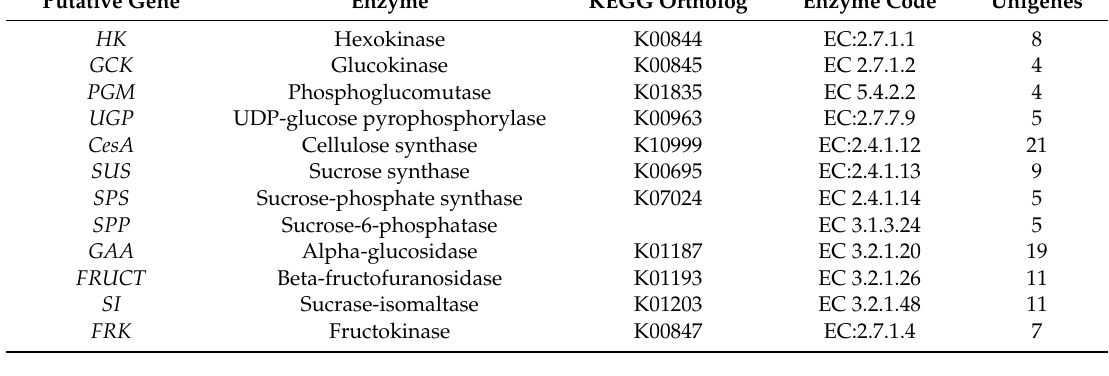
Table 2. List of candidate genes comprising cellulose biosynthesis pathways found among kenaf unigenes.